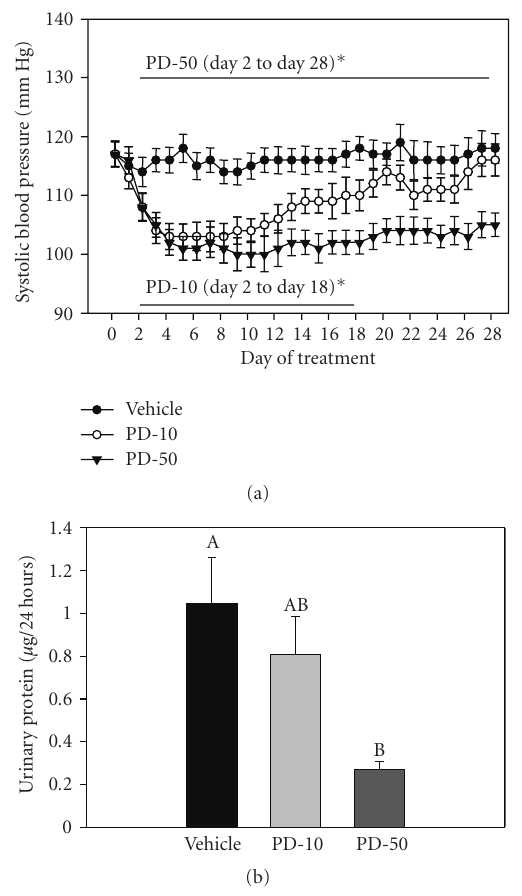
Figure 7: (a) Systolic blood pressure and (b) Urinary protein excretion in normal male SD rats chronically treated with vehicle (VEH), PD168 at the dose of 10 mg/kg · body weight (PD-10) or 50mg/kg · body weight (PD-50), ( n = 10/treatment group). Means were compared using one-way ANOVA followed by Holm-Sidak test. Data are represented as means ± SEM. Di ff erent letters represent significant di ff erences between the groups with “A” being highest mean and “AB” not di ff erent from “A” or “B” and so forth ( p < 0 . 05 was considered